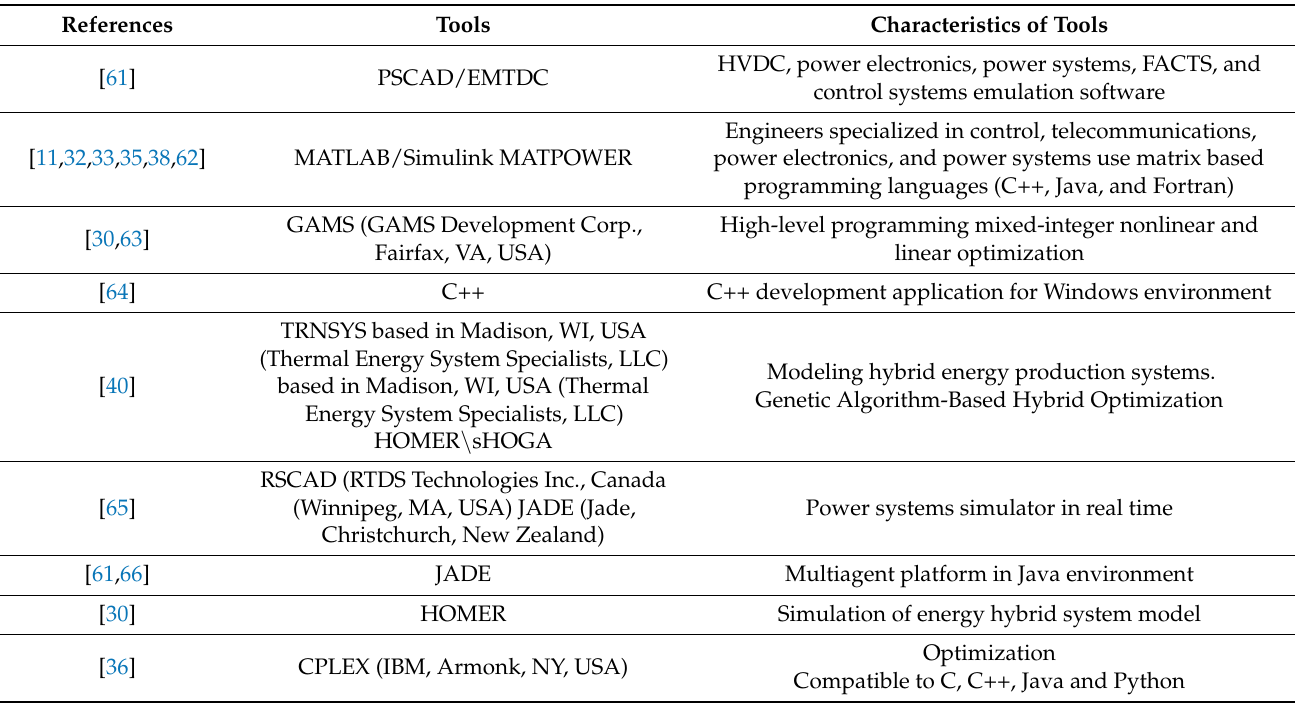
Table 4. Tools and simulation software for managing